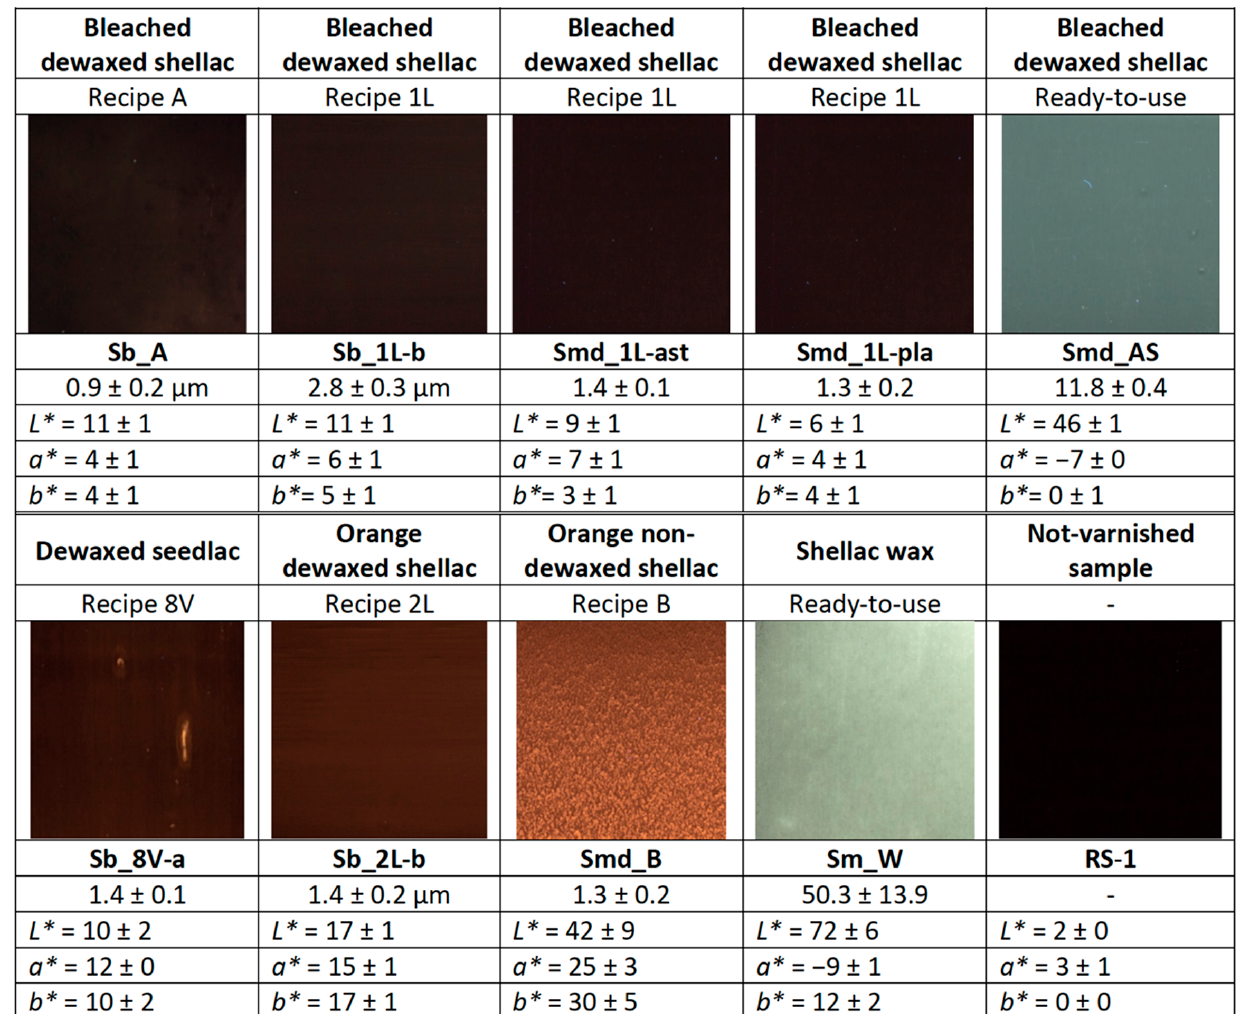
Figure 2. Results of the UV imaging and the colorimetric analysis performed on samples with different grades of shellac.